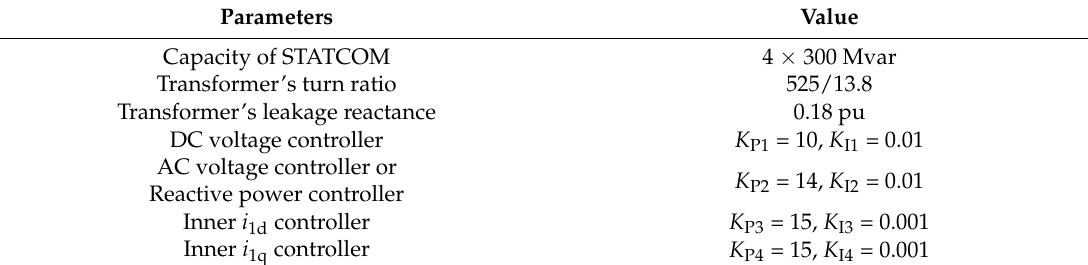
Table A2. Parameter Specifications of the STATCOM.